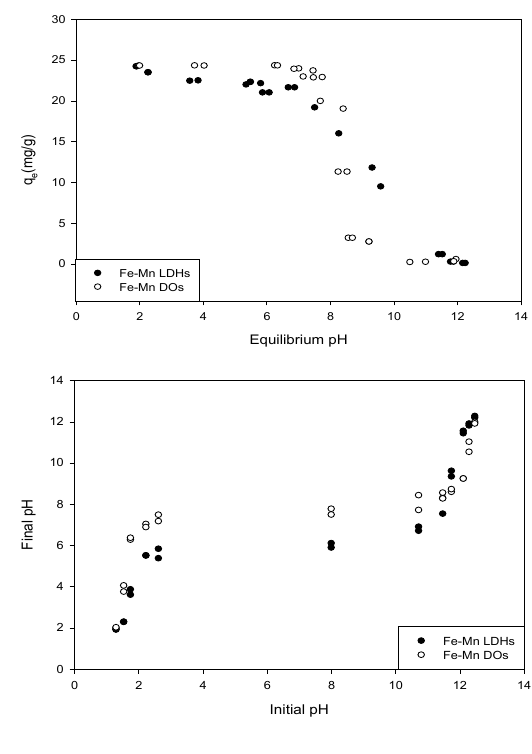
Fig. 7. T he pH effect on the removal of Se (IV) by Fe-Mn LDHs and Fe-Mn DOs pH Effect: The pH effect on the adsorption of Se(IV)